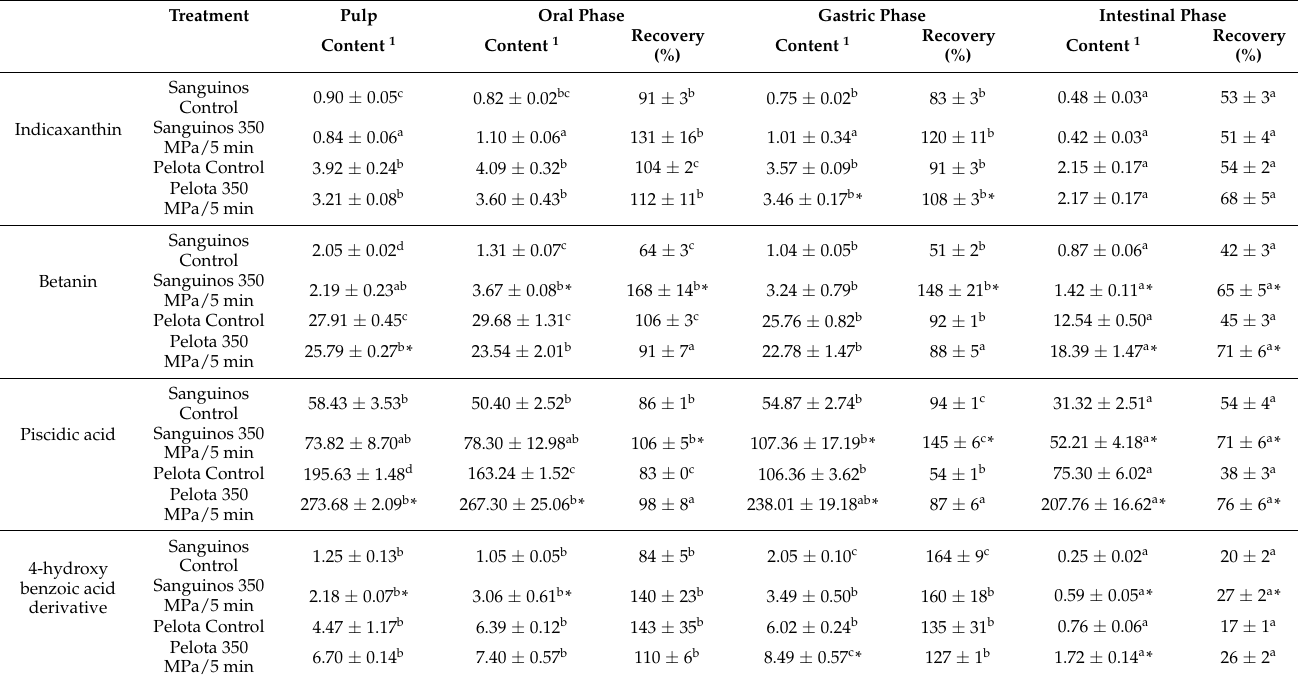
Table 4. In vitro digestive stability (mg/100 g fresh weight) of betalains and phenolic compounds in HHP-treated (350 MPa/5 min) Sanguinos and Pelota prickly pear pulps.